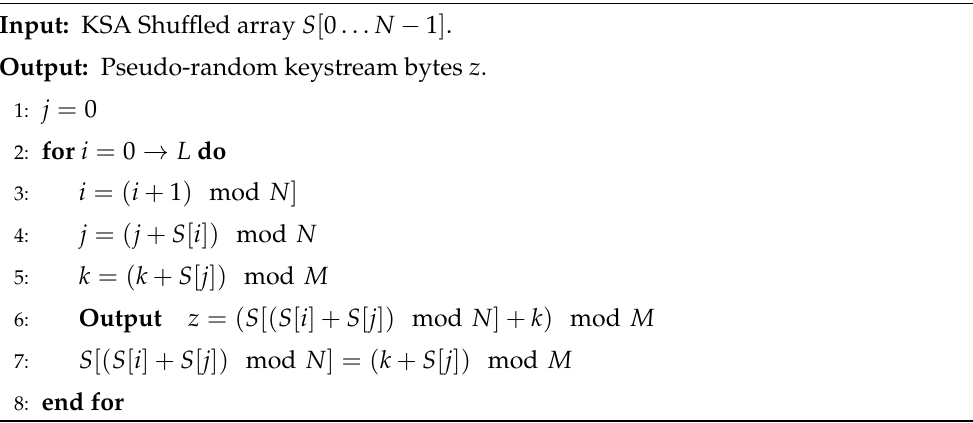
Algorithm 14 GGHN PRGA